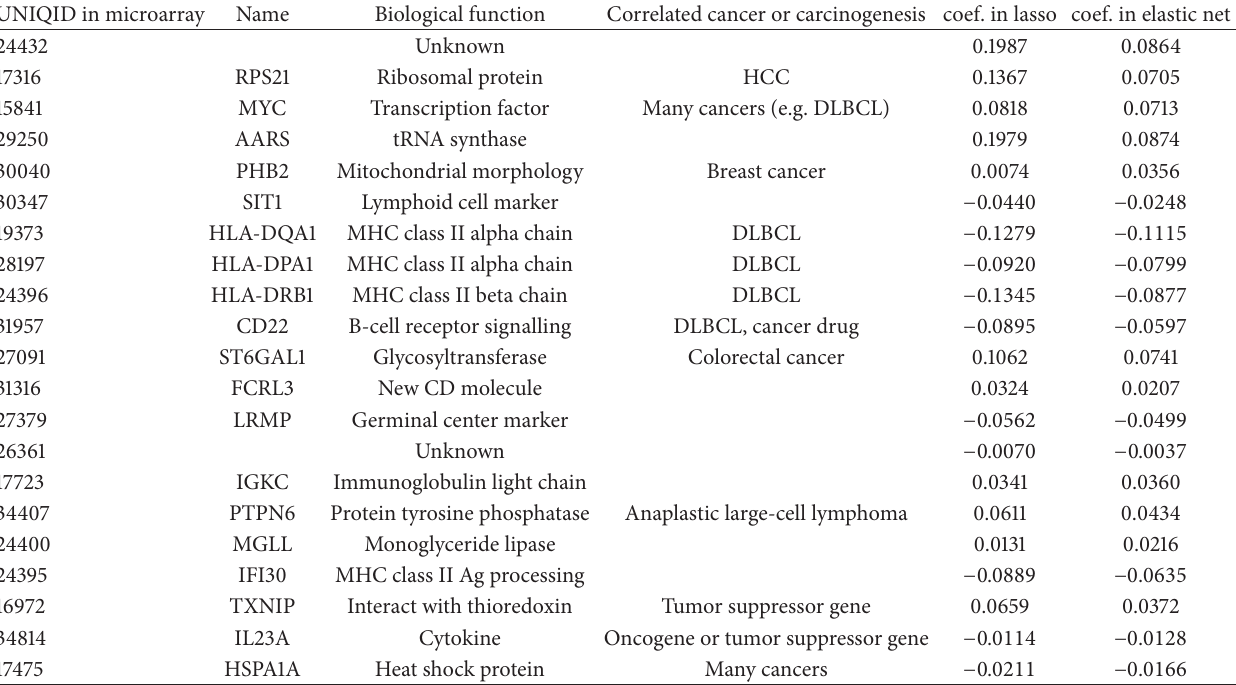
Table 1: 21 important genes selected by lasso regression